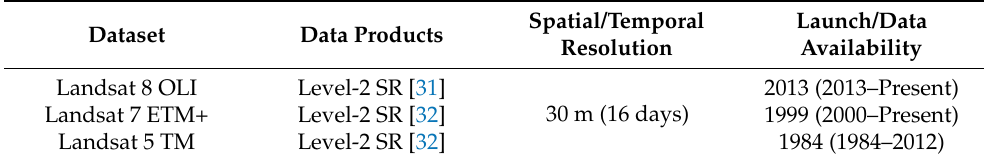
Table 1. Landsat satellite missions considered for the study. Dataset Data Products